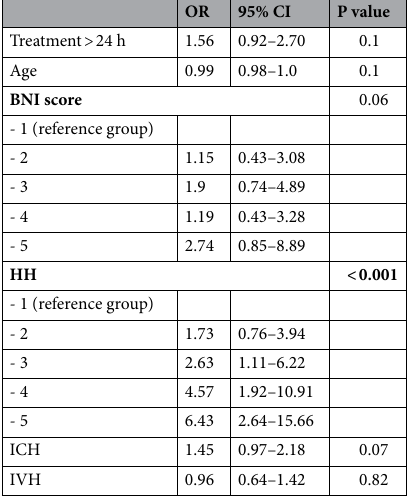
Table 4. Multivariable analysis cerebral infarct. BNI Barrow Neurological Institute, HH Hunt and Hess, ICH intracerebral haemorrhage, IVH intraventricular haemorrhage. Significant values are in bold.